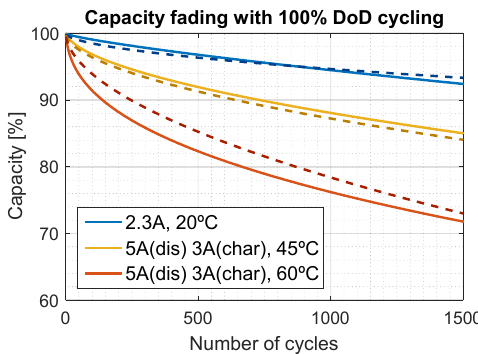
Figure 2. Comparison between the battery model implemented in this work and the manufacture’s datasheet: capacity loss due to cycling. Dashed curves are those obtained with the model [33].